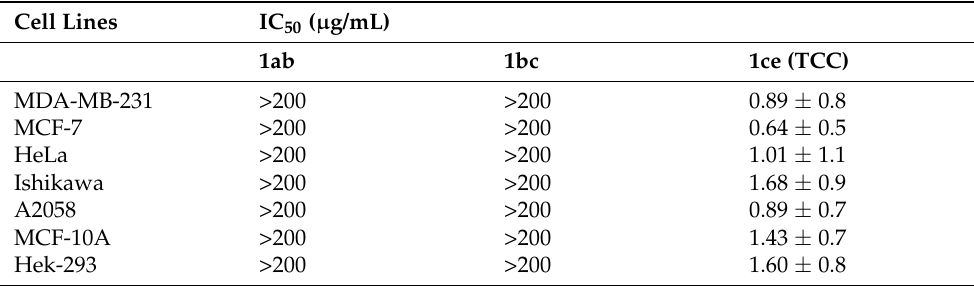
Table 2. IC 50 values ( µ g/mL) of compounds 1ab , 1bc and TCC on human breast, uterine and melanoma cancer cells as determined by using the MTT assay. IC 50 values are the mean ± SD of three independent experiments performed in